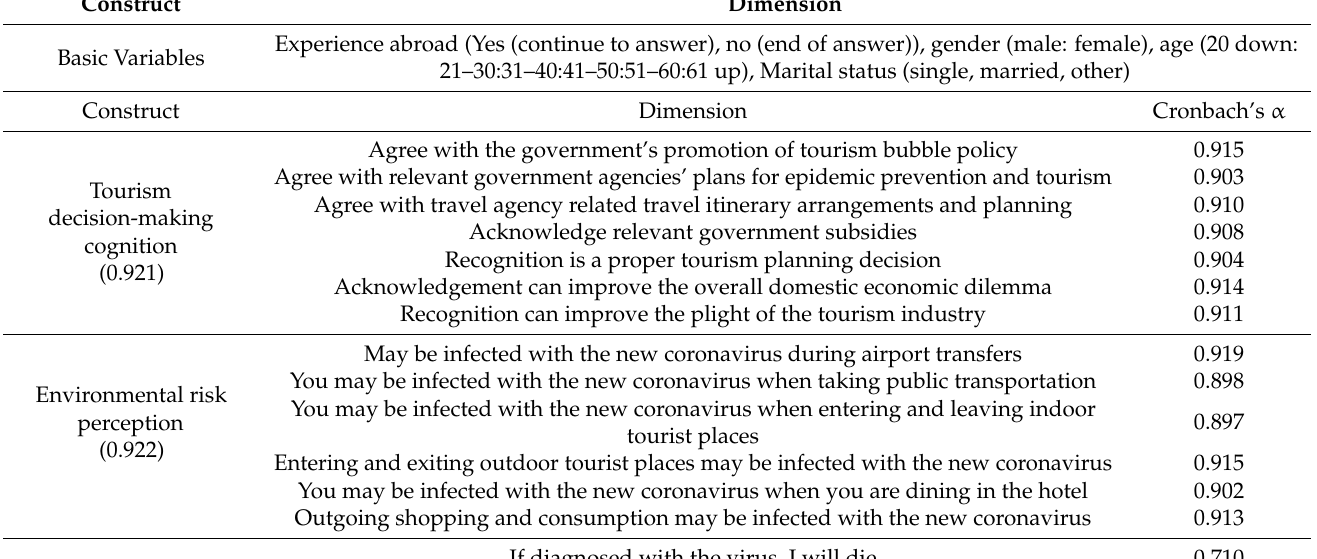
Table 1. Analysis of the questionnaire